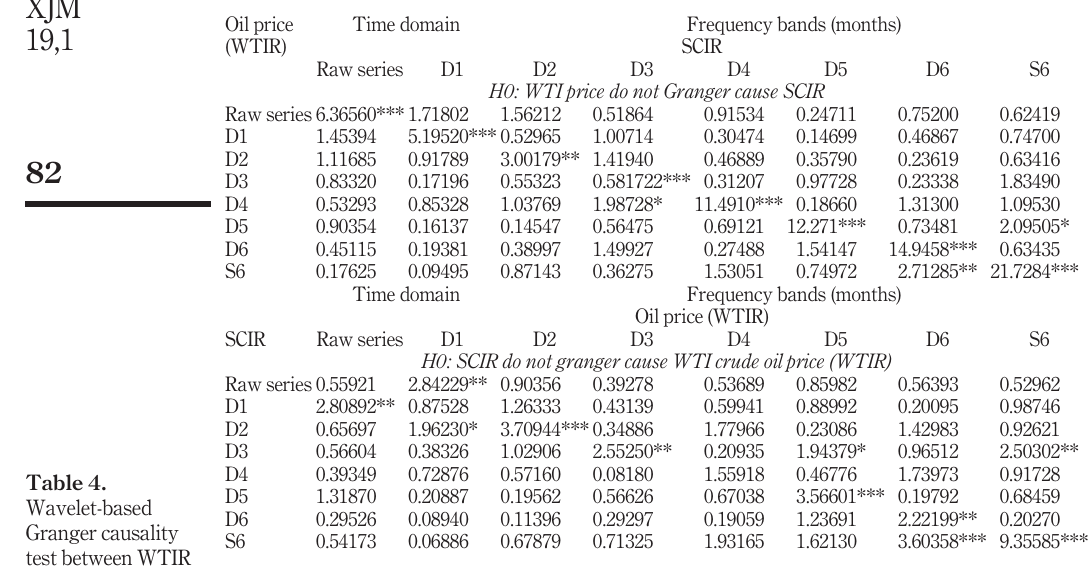
Table 4. Wavelet-based Granger causality test between WTIR and